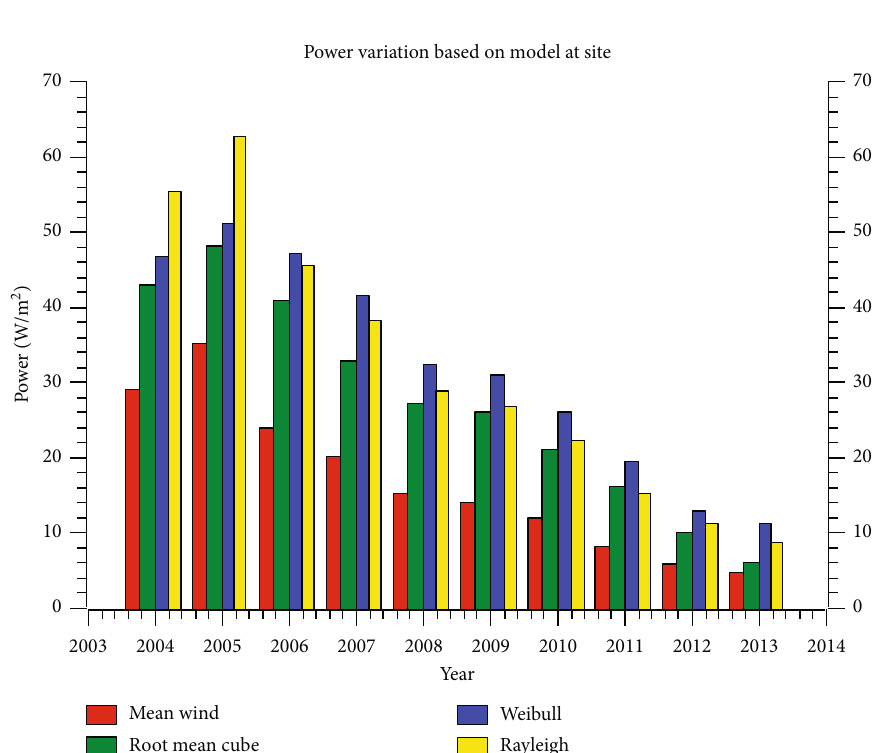
Figure 9: Wind power variation based on the model in the region (Tables 1 – 12 in Supplementary